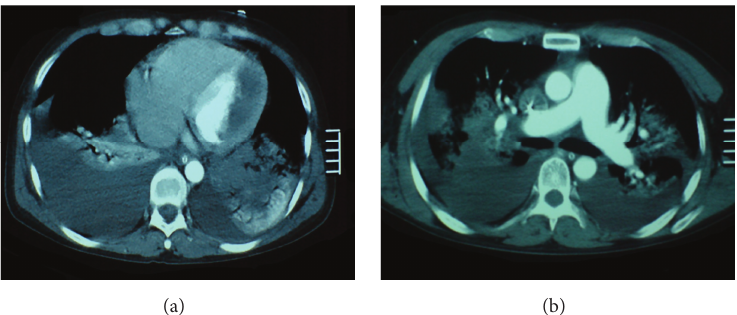
Figure 2: Chest computer tomography with contrast showing (a) a thrombus in the left ventricle and (b) bilateral pleural effusion and dilated main pulmonary artery and its branches.